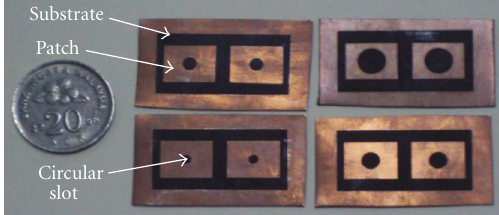
Figure 3: Fabricated unit cells rectangular patch elements embed- ded with di ff erent circular